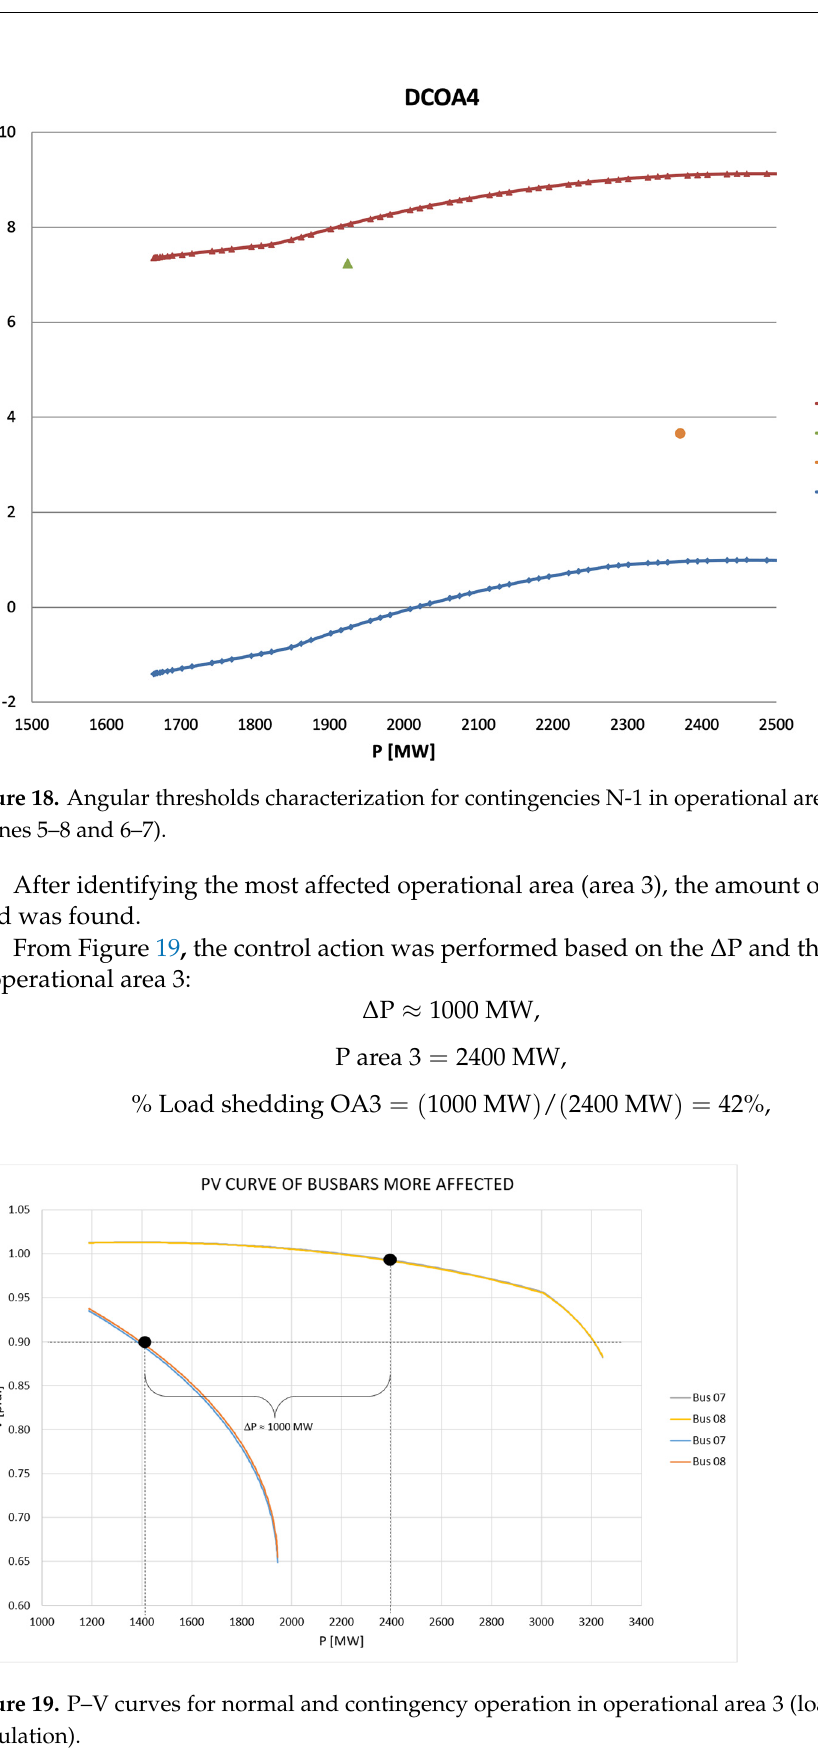
Figure 17. Angular thresholds characterization for contingencies N-1 in operational area 3 (outages of lines 5–8 and 6–7).